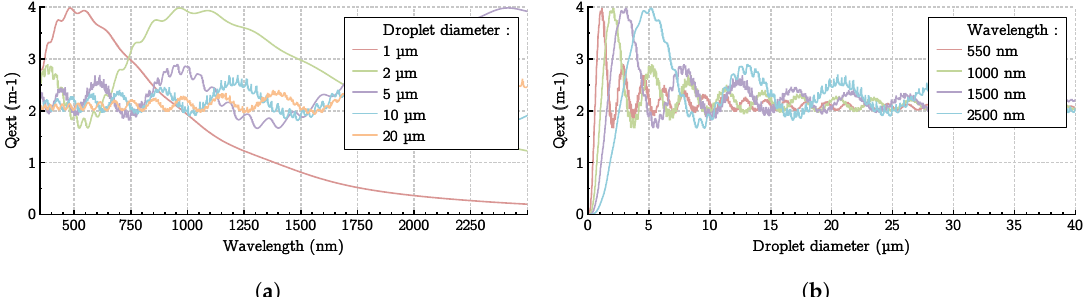
Figure 3. Extinction efficiency factor of spherical particles according to Mie theory. ( a ) As a function of wavelength; ( b ) as a function of the